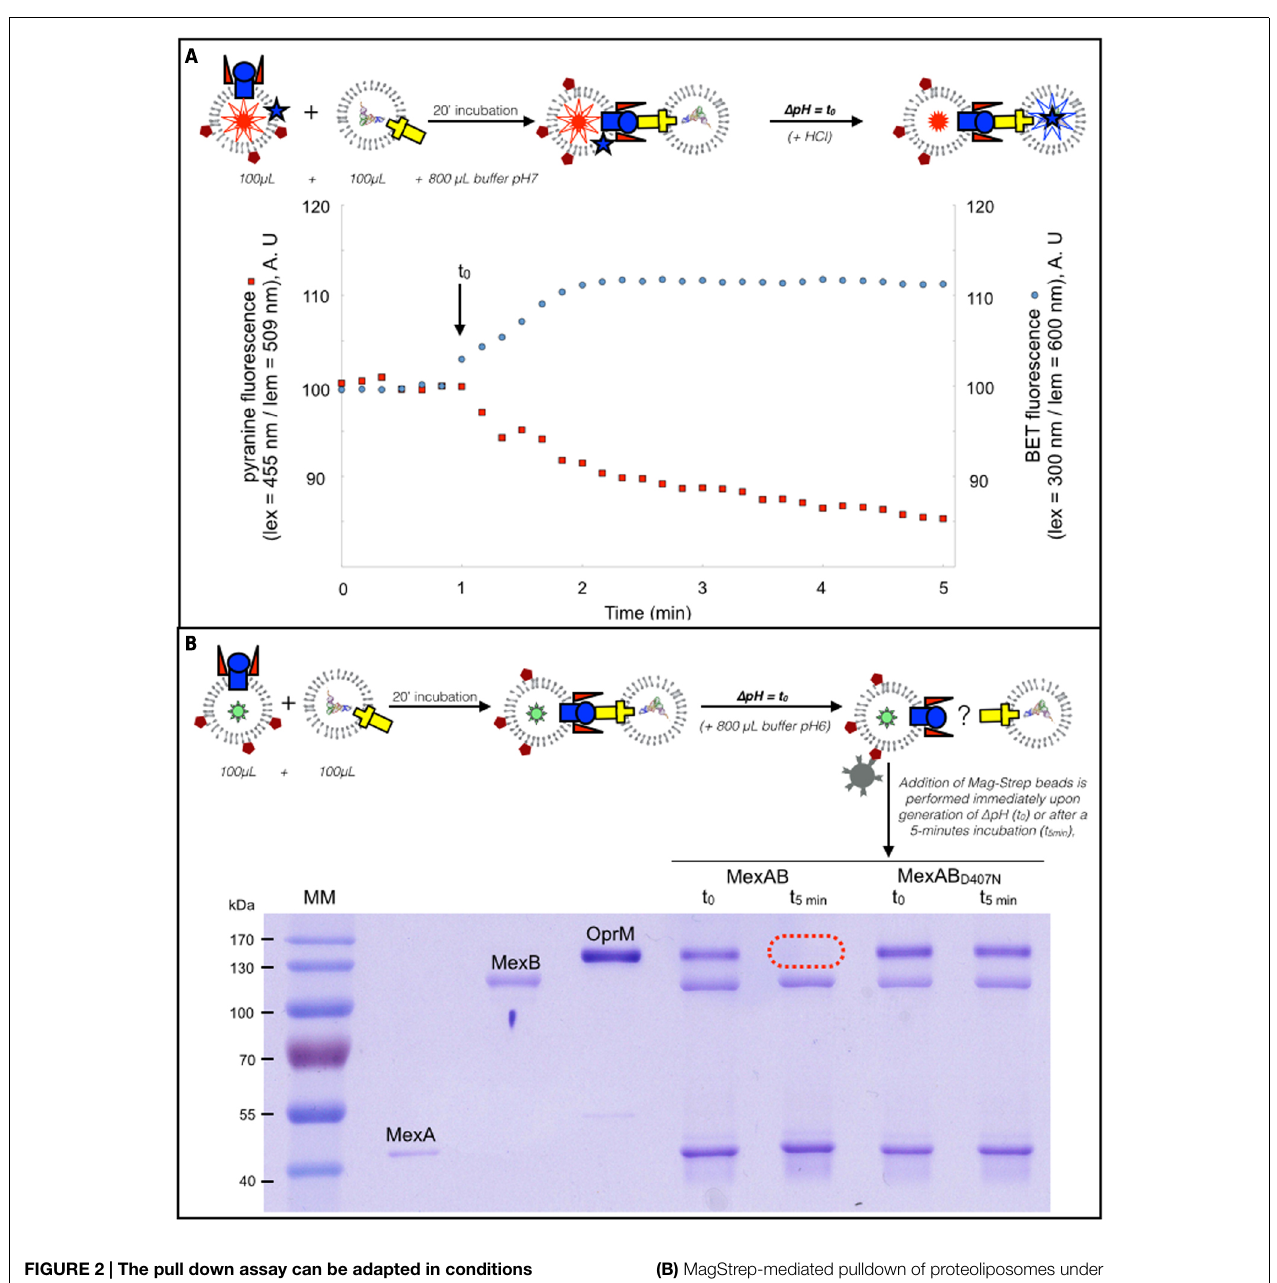
FIGURE 2 | The pull down assay can be adapted in conditions mimicking the transport. (A) Dual wavelength fluorescence monitoring of transport. Fluorescence measurements were conducted with excitation and emission wavelengths set for the recording of EthB and pyranine fluorescence. OprM proteoliposomes and of MexAB proteoliposomes were mixed and incubated with EthB (5 µ M) and a pH jump, indicated by an arrow, was performed after 20 min incubation. The concomitant fluorescence variations of pyranine (see A , red trace) and EthB (see A , blue trace) is the proof of actual transport of the substrate from one vesicle to the other.